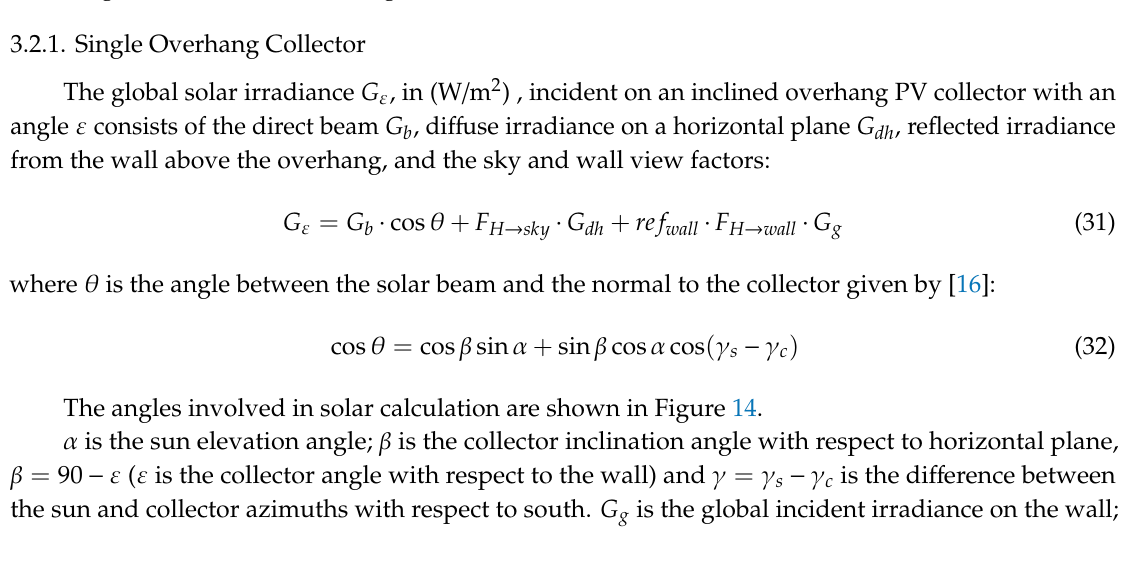
Figure 13. Daily variation of percentage shaded area on the ground on April (…) and June (___) 21st, ( H = 5.0 m , D = 3.0, 5.0 m